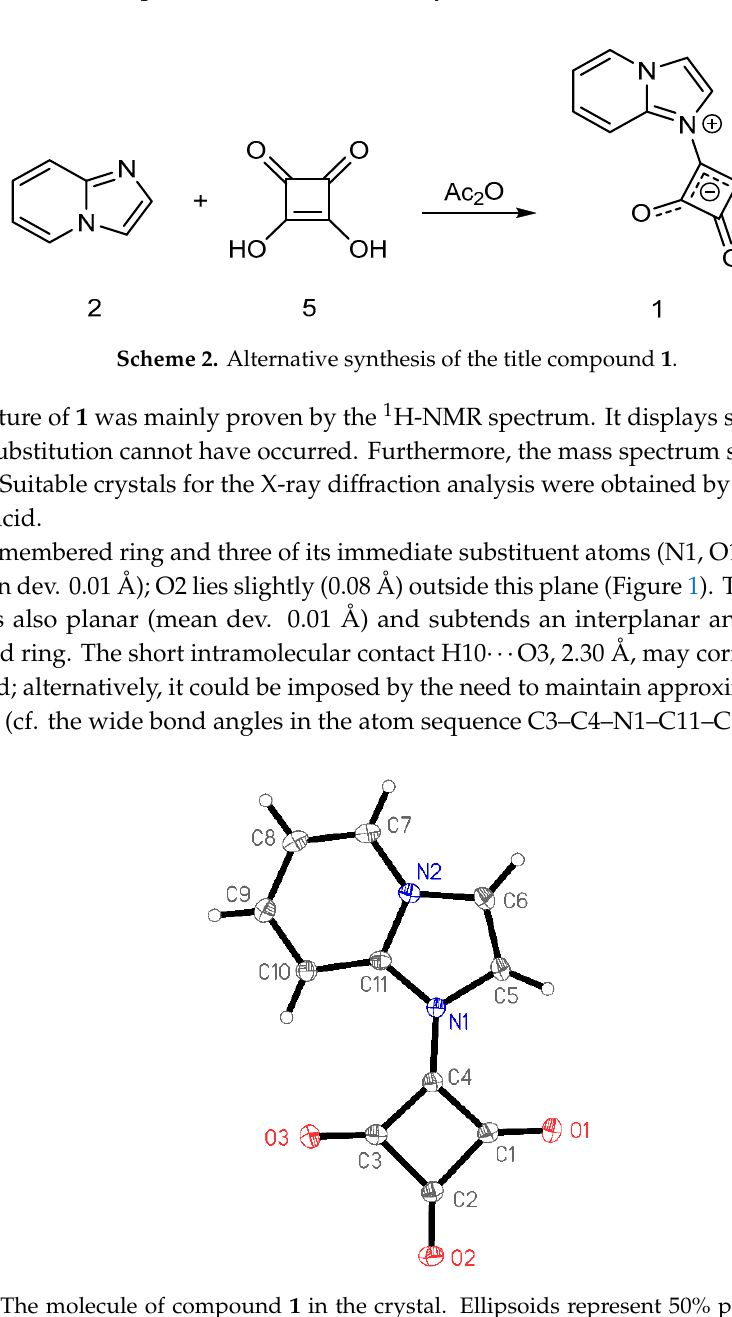
Figure 1. The molecule of compound 1 in the crystal. Ellipsoids represent 50% probability levels. Selected bond lengths (Å) and angles (°): C1–O1 1.2321(14), C1–C4 1.4357(15), C1–C2 1.5230(15),